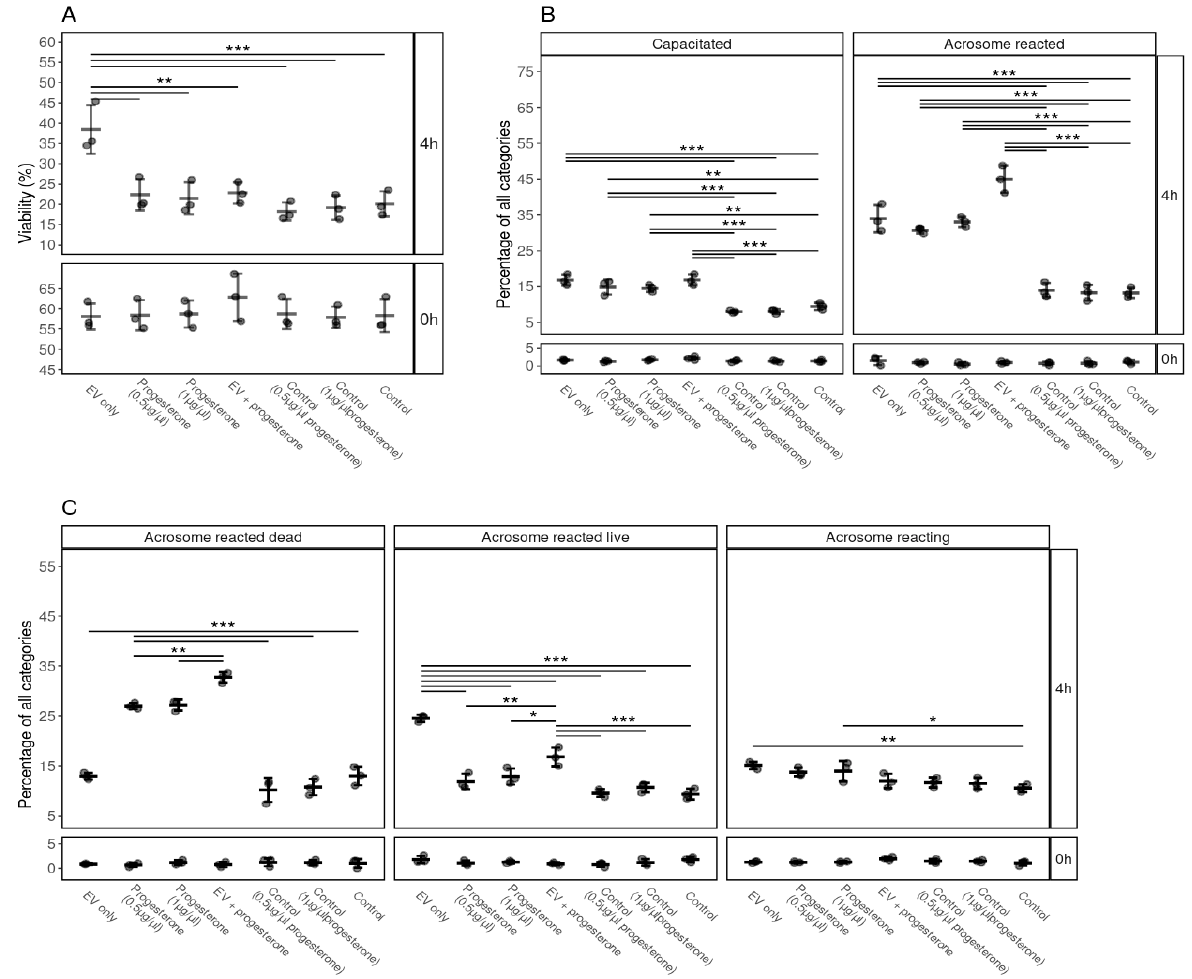
Figure 6. The effects of supplementation of EVs and different concentrations of progesterone and combination of FF EVs and progesterone on the viability, capacitation and acrosomal reaction of spermatozoa. ( A ) Percentages of live spermatozoa 0 and 4 h after supplementation with EVs, progesterone (0.5, 1 μ g/ μ L), combination of FF EVs and progesterone, and controls. ( B ) Percentages of spermatozoa at different stages of capacitation reaction 0 and 4 h after with different supplementations. ( C ) Percentages of spermatozoa in different stages of the acrosomal reaction after supplementation with EV, different concentrations of progesterone and combinations of FF EVs and progesterone at 0 and 4 h. Error bars display the mean ± standard deviation (SD). Different symbols represent measurements of samples from different bulls. Asterisks mark statistically significant differences between the supplementation groups and relate to p ‐ values as follows: * p ≤ 0.05; ** p ≤ 0.01; *** p ≤ 0.001. Double lines annotate p ‐ values of the same category. In that case, asterisks above the top line also apply to the bottom line. The ends of the lines mark the groups that were contrasted.